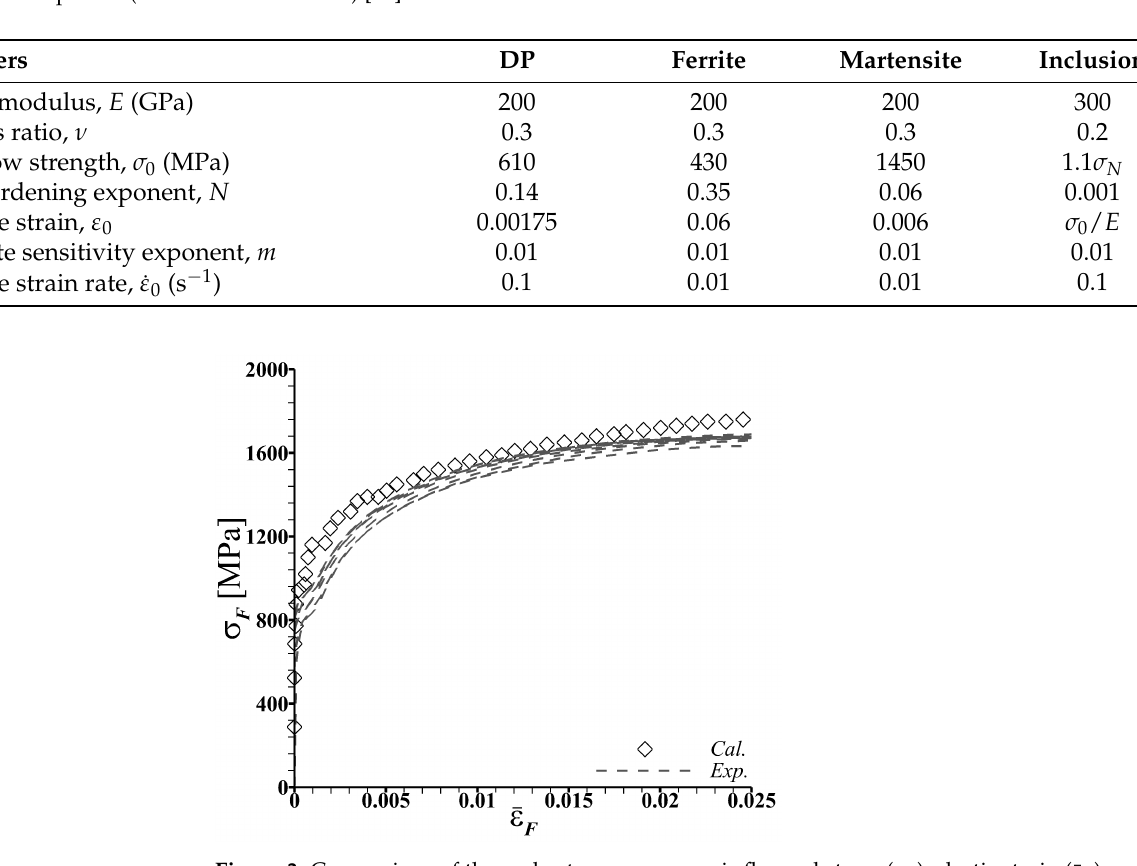
Figure 3. Comparison of the early stage macroscopic flexural stress ( σ F )-plastic strain (¯ ε F ) response of the DP1000 steel sheets obtained from 90 ◦ V-bend tests ( Exp ) and microstructure-based finite element calculation ( Cal ). In the microstructure-based finite element calculation the dual-phase microstructure of the steel without any inclusion is discretely modeled in the bend specimen, see Figure